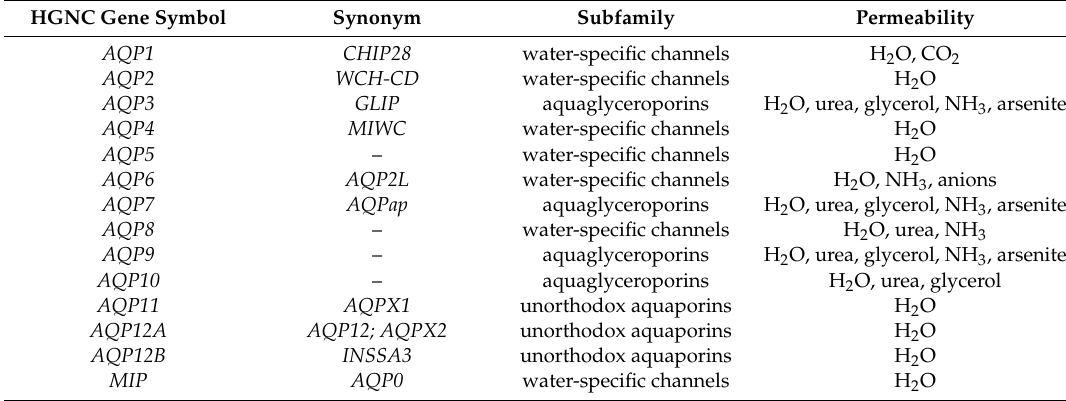
Table 1. Summary of mammalian AQPs and their basic